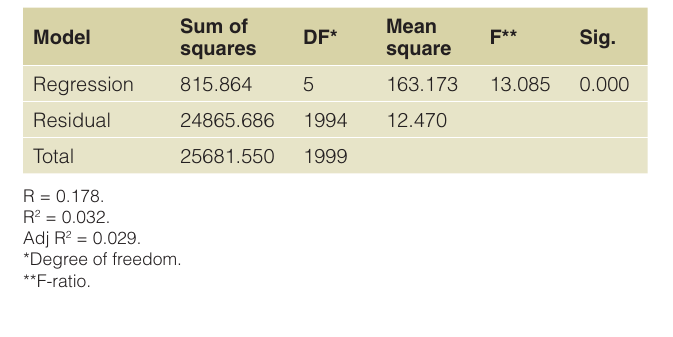
Table 13. Joint effect of independent variables (age, gender, religion, ethnicity and parent’s occupation) on perspective of abstinence-only sexual education.